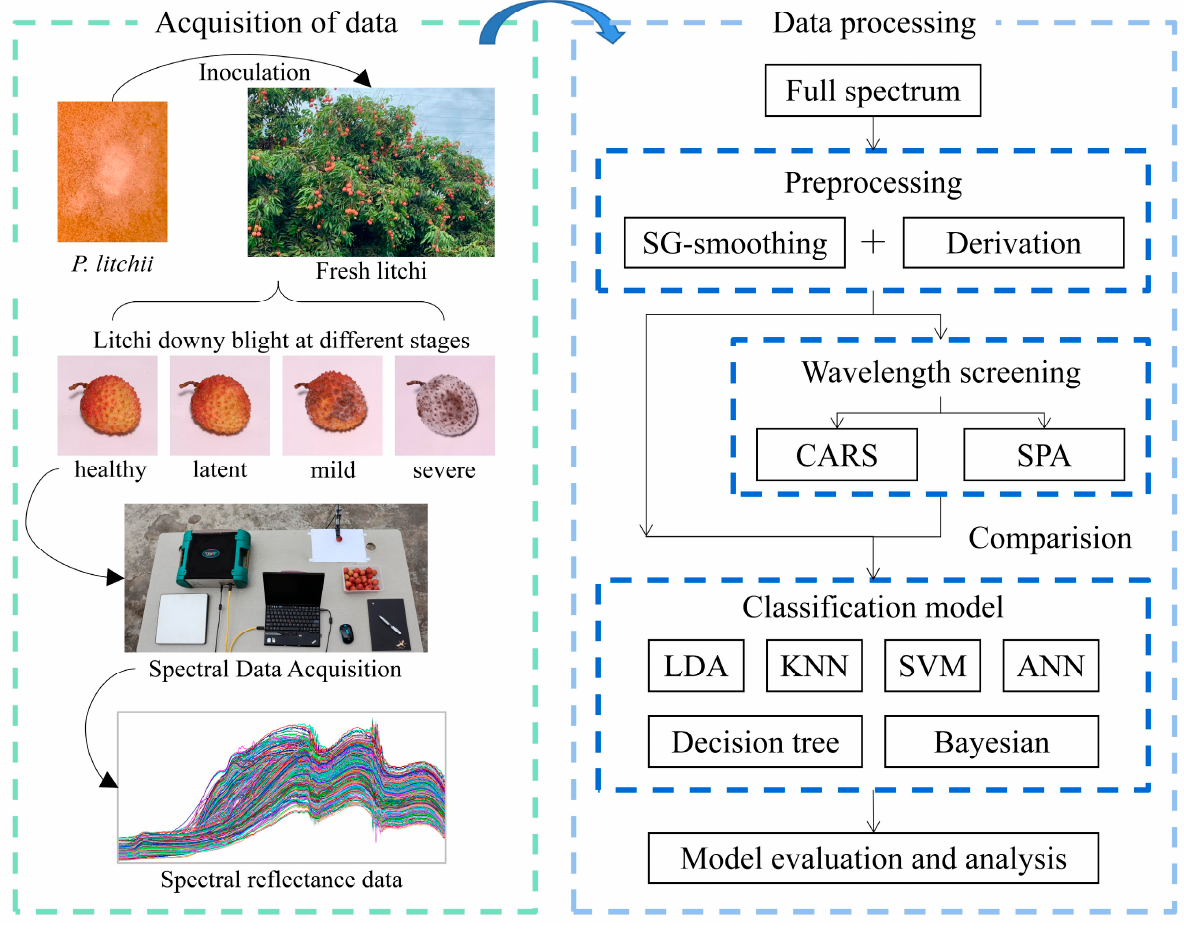
Figure 1. Overall flow chart.